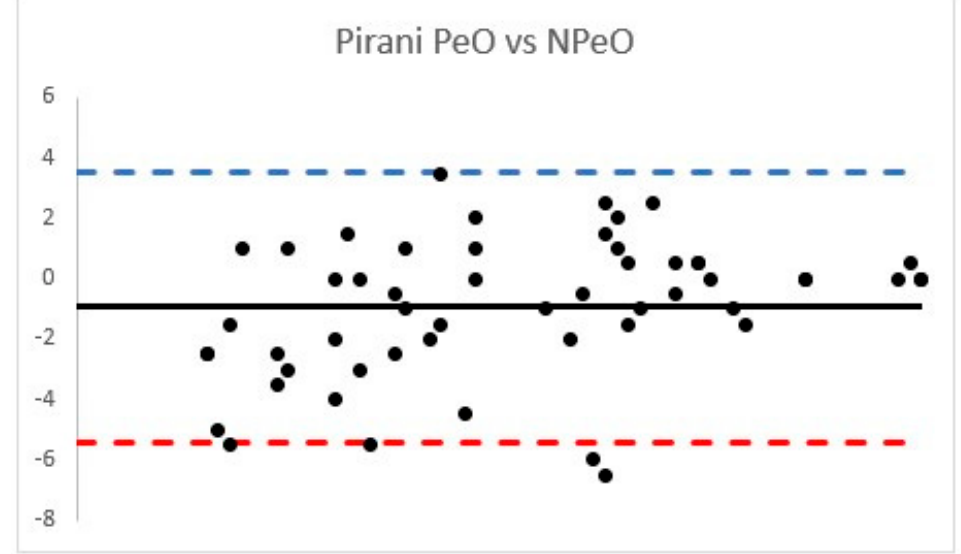
Figure 3. Bland Atman plots according to OS and RS Pirani score.